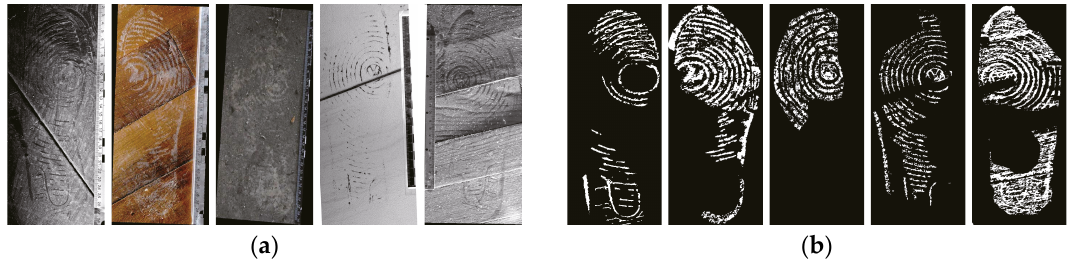
Figure 3. Examples of crime scene shoeprint images in the MUES-SR10KS2S dataset. ( a ) The probe shoeprint and its counterparts from real crime scenes in the gallery set. ( b ) Corresponding binarized versions of the probe shoeprint and its counterparts in the gallery set.